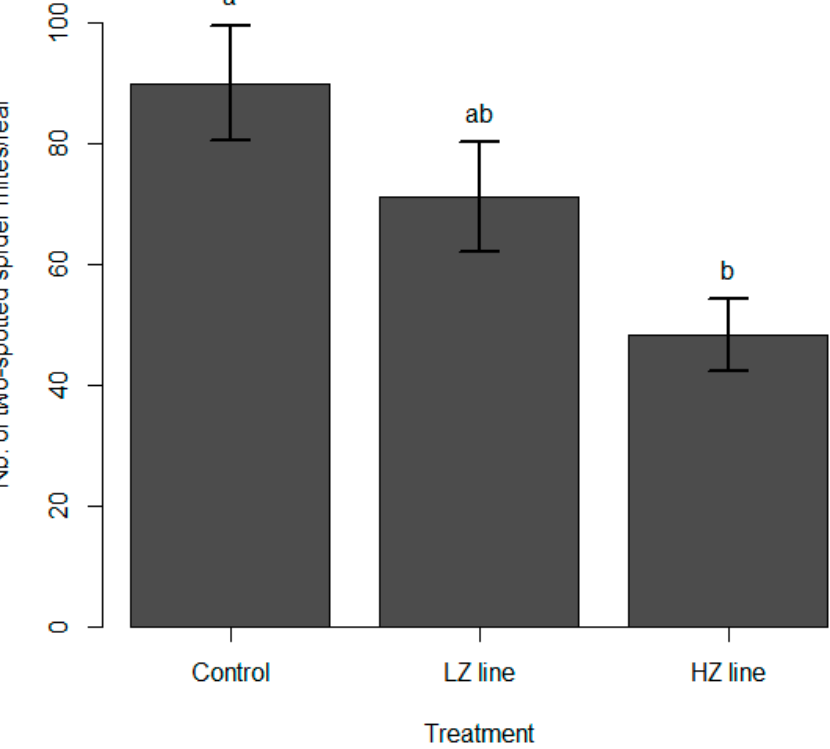
Figure 1. Number of two-spotted spider mites 14 days after the introduction of three mullein bug nymphs (N3 to N5) in sleeve cages. LZ line refers to the lowly-zoophagous isogroup line, whereas HZ indicates the highly-zoophagous line. In the control treatment, no mullein bug nymphs were introduced. Means with the same letter are not statistically different. Error bars indicate standard error.